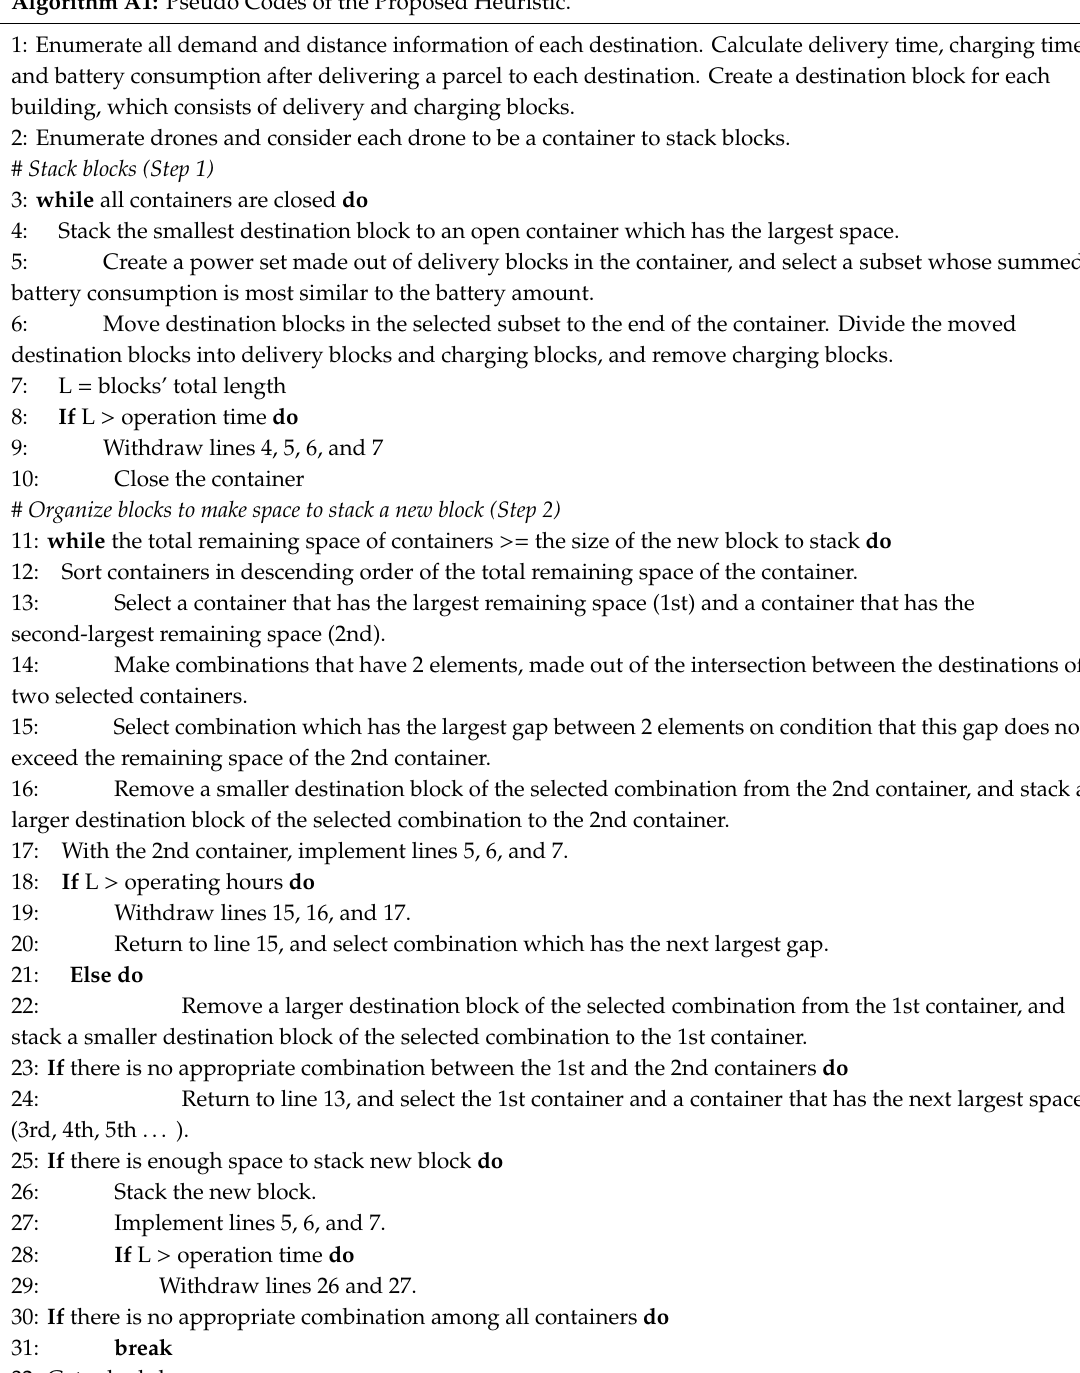
Algorithm A1: Pseudo Codes of the Proposed